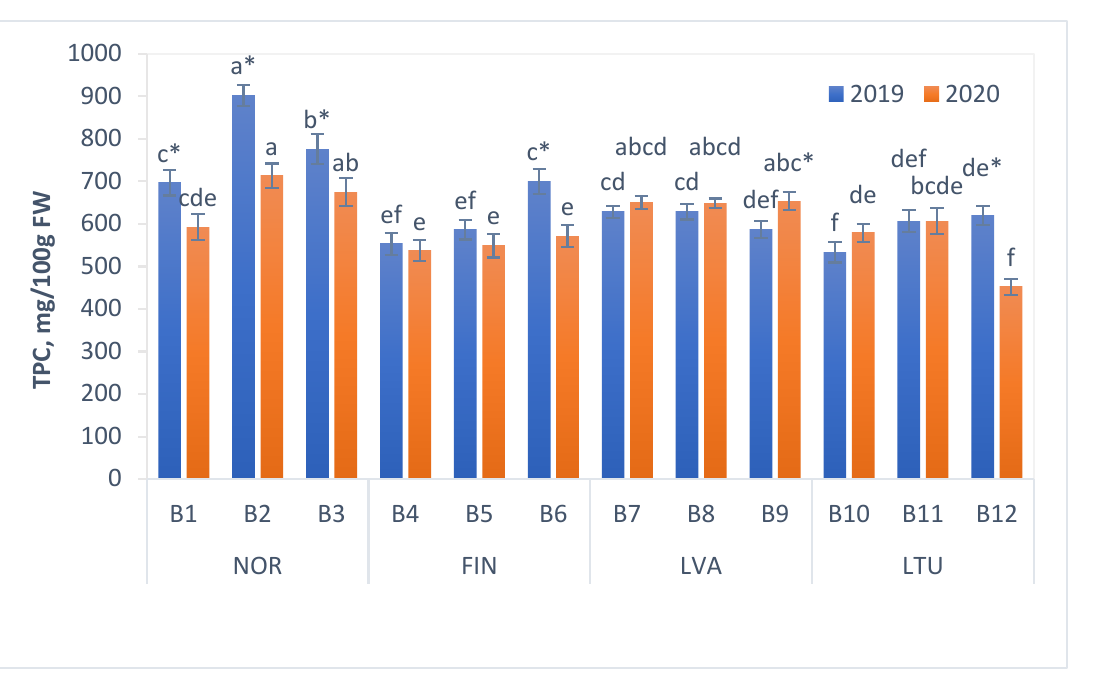
Figure 3. Total phenolic content (TPC) of bilberries mg/100 g FW. Values are presented as means ± standard deviations. Different letters within the same column indicate significant differences between the collection locations (B1–B12) ( p < 0.05). Significant differences between 2019 and 2020 are indicated by asterisks (*) ( p < 0.05). Locations of bilberry sample collection include Norway (NOR), Finland (FIN), Latvia (LVA) and Lithuania (LTU).